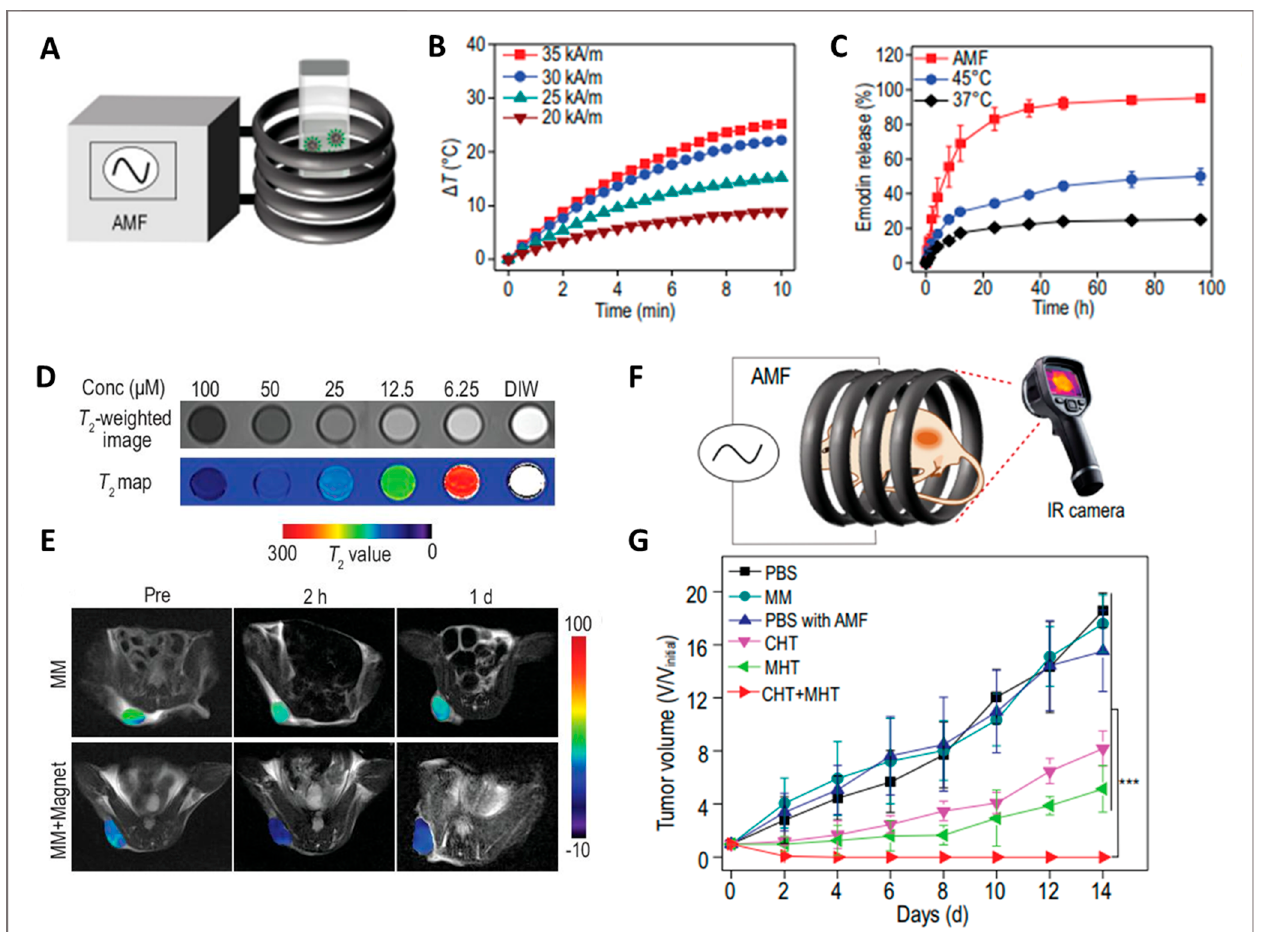
Figure 6. Magnetic polymeric micelles for hyperthermia treatment. ( A ) Schematic illustration of the magnetic hyperthermia in vitro assay; ( B ) Time-dependent temperature curves with different AMF intensities; ( C ) The release curves of emodin from emodin-magnetic micelles (EMM) after a 10 min treatment at 37 °C and 45 °C, and in response to an AMF; ( D ) T 2 -weighted image map of EMMs; ( E ) The in vivo T 2 -weighted images of the tumor after intravenous injection of non-loaded emodin- magnetic micelles (MM) in the absence and presence (MM + Magnet) of magnetic targeting; ( F ) Schematic illustration of EMM mediated magnetic hyperthermia (MHT) and chemotherapy (CHT) in vivo study with 4T1 tumor-bearing mice; ( G ) The tumor growth curves (statistical analyses were performed using Student’s t-test; ∗∗∗ P < 0.001). Adapted from reference [31].